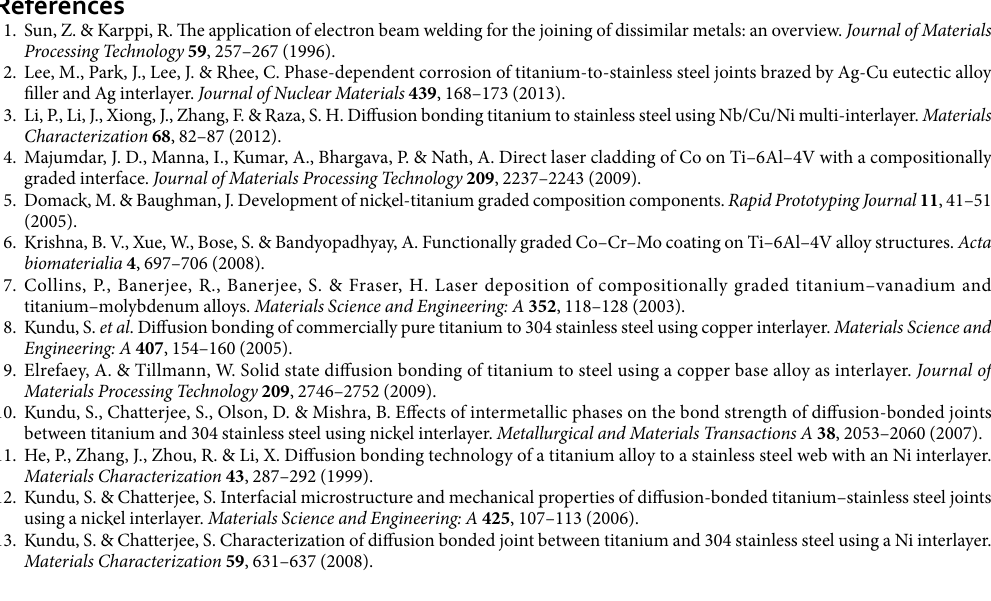
adjacent points is 0.1 mm. Dwell time for each point is 5 s. X-ray diffraction(XRD) tests detected the formed phase and analyze if the intermetallics formed in the printed sample. The XRD analysis sample was cut from a central cross section of Ti6Al4V/SS316 multi-metallic part. The XRD test was performed on the surface area of cross section, as shown in Fig. 7. Based on the EDS points test results, four sites with the maximum weight percentage of Ti, V, Cr, Fe, were selected for XRD test. The positions of the four XRD test sites were same with the positions of four SEM test sites in Fig. 10. Vickers hardness number(VHN) showed hardness distribution in the sample. All the material characterization and test instruments were detailed in Table 5.